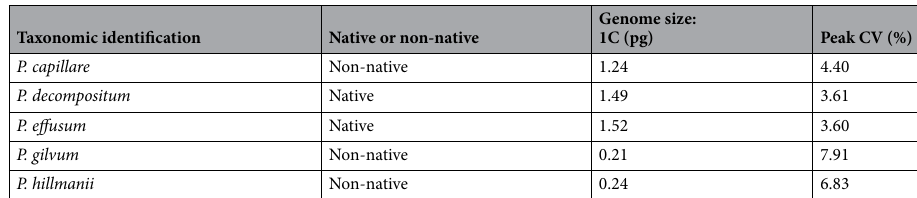
Table 3. Flow cytometric analysis of genome size of Panicum capillare, P. decompositum, P. effusum, P. gilvum and P. hillmanii as estimated by comparison to Raphanus sativus , 1C = 0.55 pg or Solanum lycopersicum, 1C = 1.06